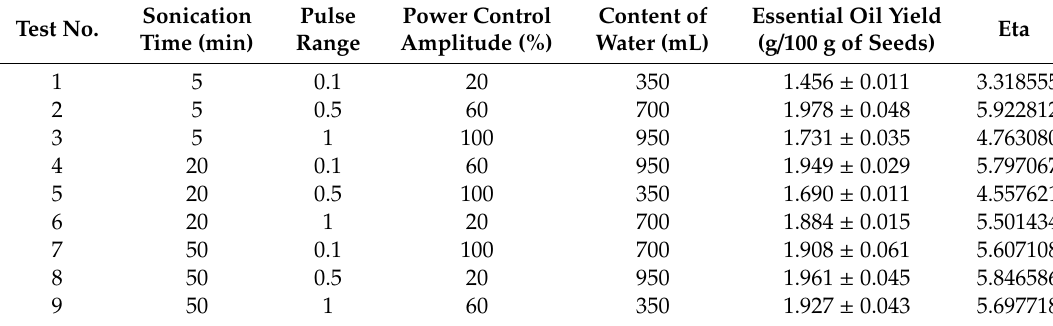
Table 1. Statistical analysis of input factors for ultrasonic pre-treatment of celery seeds according to the Taguchi